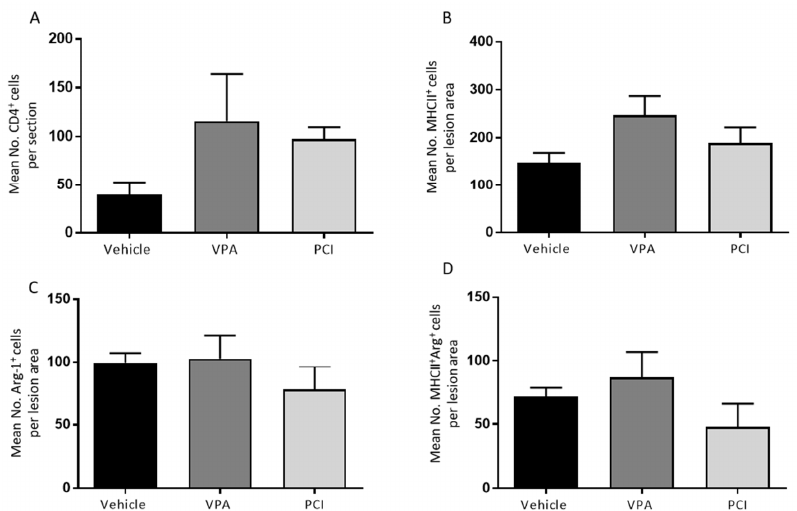
Figure 4. PCI34051 and VPA have no effect on CD4 + , MHCII + , and Arg-1 + cell numbers after SCI. Spinal cord sections were labelled for CD4 + cells (T helper cells, A ), MHCII + cells (classically activated macrophages / microglia, B ), and Arg-1 + cells (alternatively activated macrophages / microglia, C ). ( A ) The number of CD4 + cells was counted in complete spinal cord sections. ( B – D ) MHCII + , Arg-1 + , and MHCII + / Arg-1 + cells were counted at the lesion area. Data are represented as means ± SEM, n = 3–4 mice / group. ** p < 0.01. Arg-1: arginase-1; CD4: cluster of differentiation 4; MHCII: